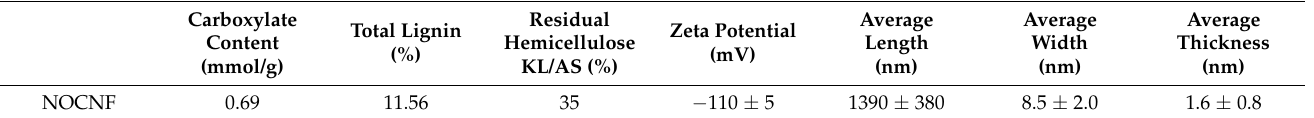
Table 1. Structure and surface properties of NOCNF extracted from sorghum stalks using the nitro-oxidation process.